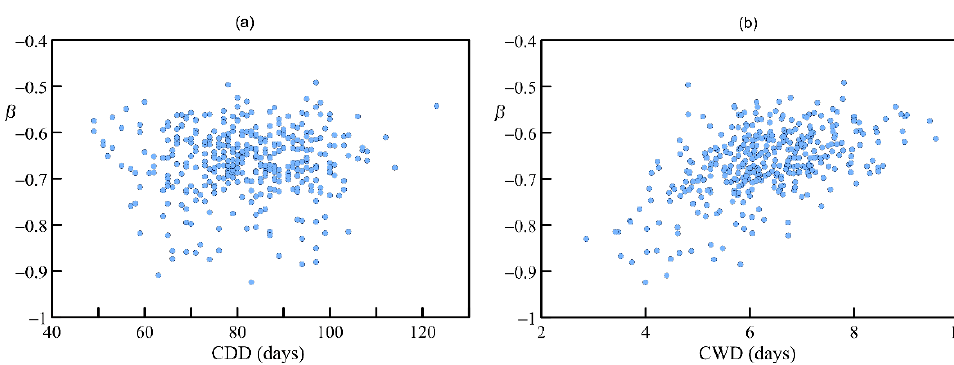
Figure 7. Representation of the scaling parameter 𝛽 vs. ( a ) the CDD drought index and ( b ) the CWD index.